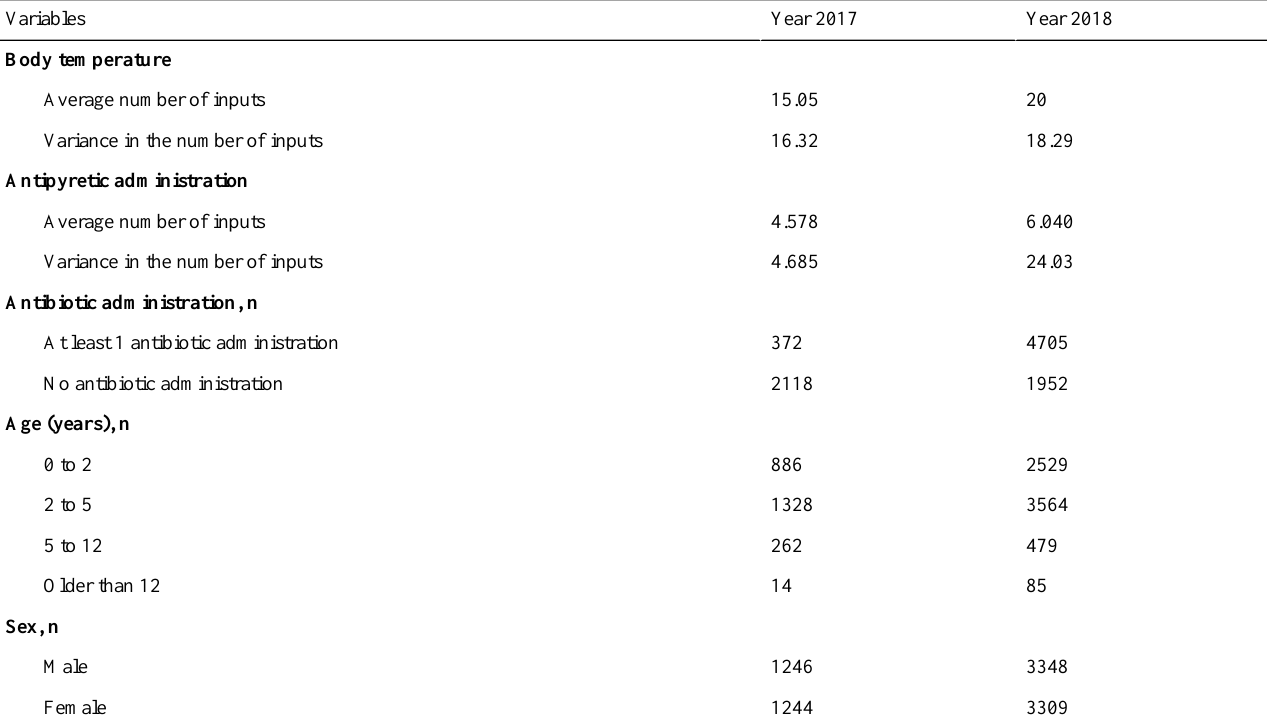
Table 2. General characteristics of the data set.